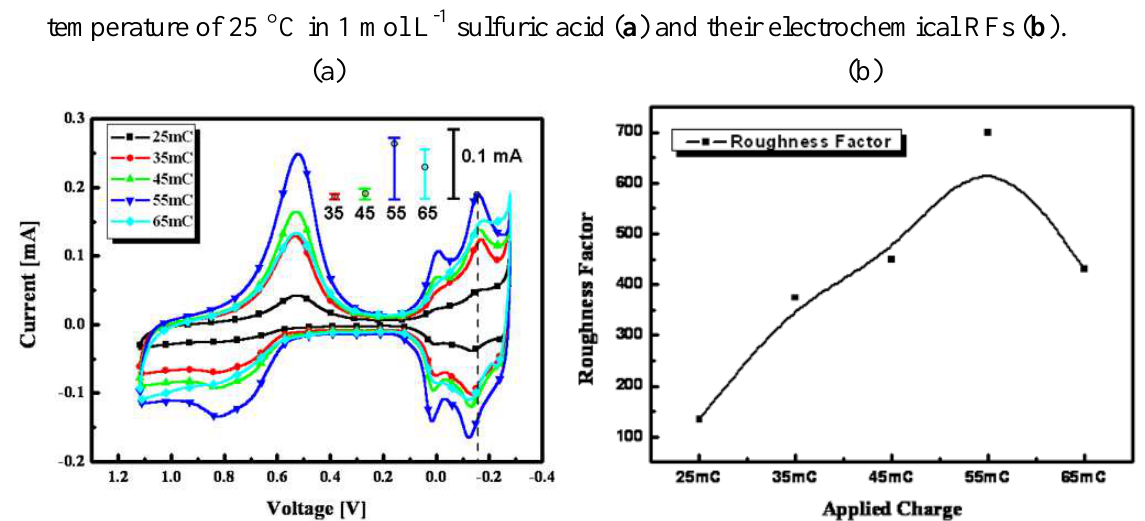
Figure 4. Cyclic voltammograms of nanoporous Pt electrodes electroplated between 25 and 65 mC/mm 2 of applied charges at the conditions of a fixed voltage of -0.12 V